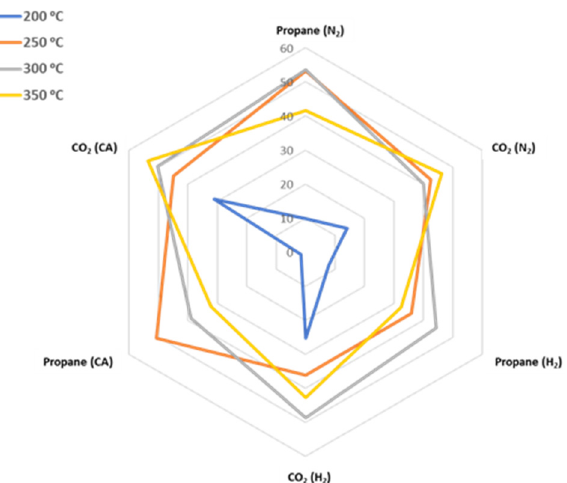
Figure 5. Radar chart plot for gas products from butyric acid conversion at different temperatures and reaction atmospheres (CA—compressed air).